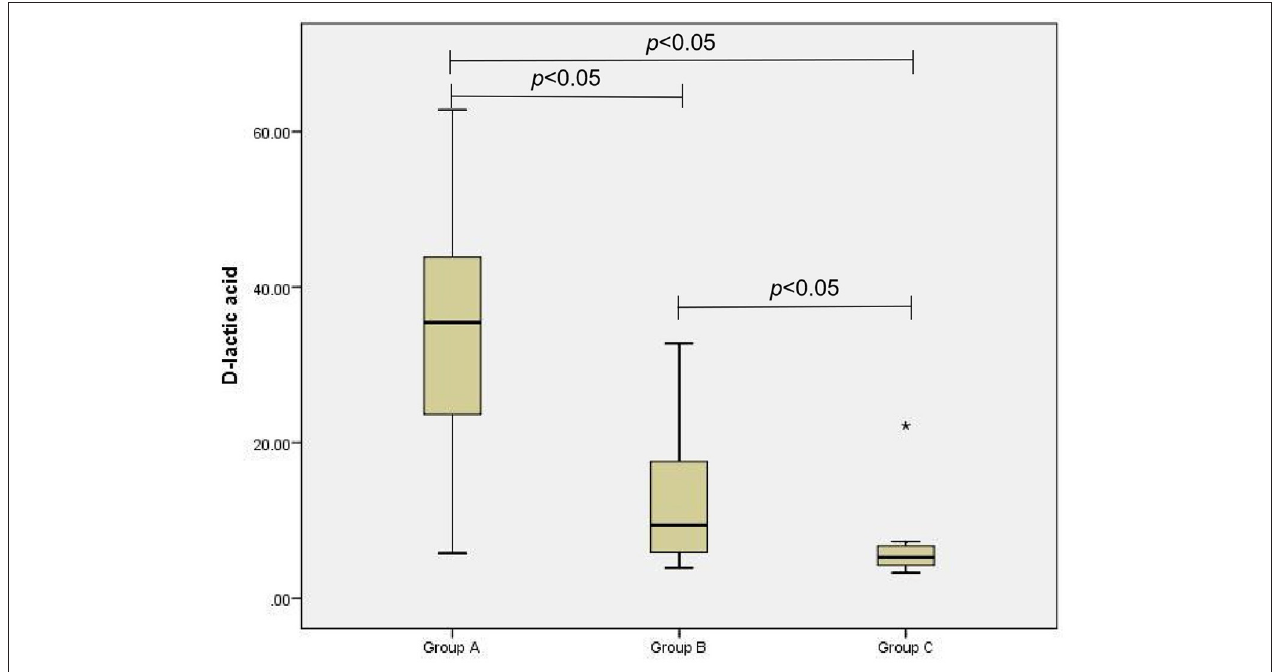
FIGURE 2 | Comparison of D-lactic acid levels in group A, B, and C.